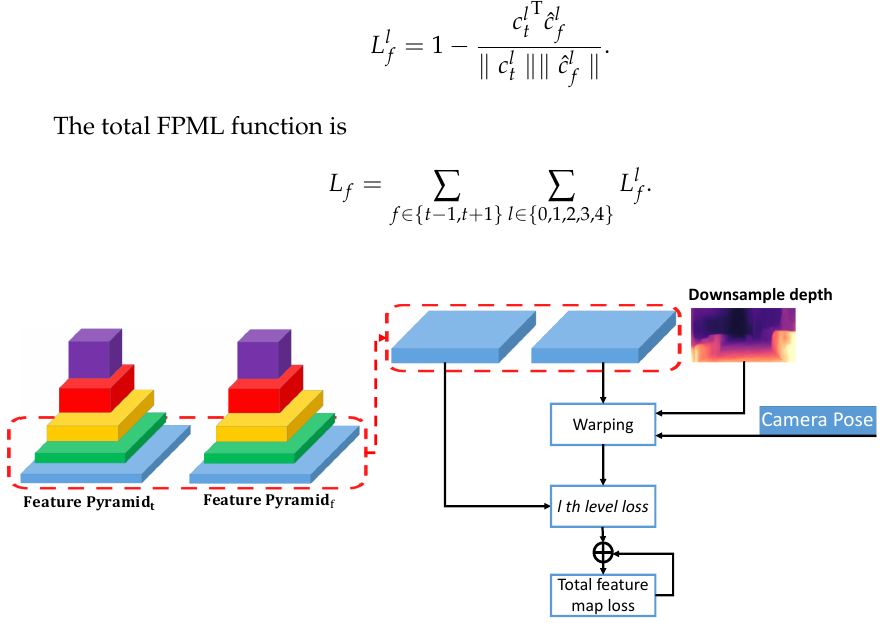
Figure 3. Feature pyramid matching error of the current frame and adjacent frame. Feature pyramid is constructed by different scale feature maps. Adjacent feature maps warped using the downsampled depth and camera pose computes a matching